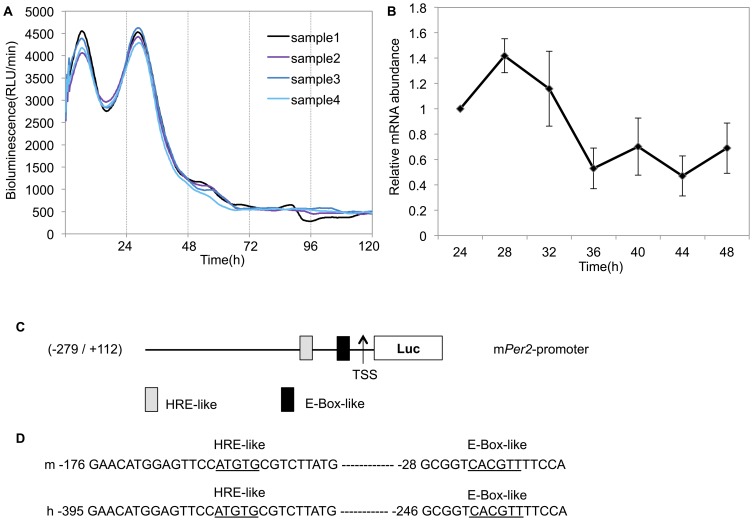
Rhythmic expression of Per2 in Caki-2 cells.(A) All renal cancer cell lines were transfected with the Per2 promoter reporter (2 µg) and the bioluminescence was then measured using a real-time monitoring assay. Real-time monitoring of luciferase activity of the Per2 promoter showed that activity oscillated over an approximately 24-h cycle. The luciferase activities of four replicate samples are shown. These cultures showed significant circadian rhythms (Table 1). (B) mRNA levels of Per2 were determined by real-time PCR for six plates at each time point. Total RNA was extracted every 4 h, beginning 24 h after treatment with dexamethasone for one 24-h cycle, and Per2 transcripts were quantified. Error bars indicate the standard errors of the mean values (n = 6). The data from a single 24 hours after dexamethasone treatment were analyzed using the Cosinor software for rhythmicity (Table 1). (C) The structure of the Per2 promoter and an analysis of the potential transcription factor-binding motifs in this region. The 2,994-bp region contains one E-box-like sequence (CACGTT) and one HRE-like sequence (ATGTG), similar to the consensus HRE sequence (ACGTG) located upstream of the transcription start site (TSS). (D) Sequence comparisons: upper line, mouse sequence; lower line, human sequence. The nucleotide sequence of potential transcription factor-binding motifs for E-box-like sequence and HRE-like sequence are 100% conserved between mouse and human.